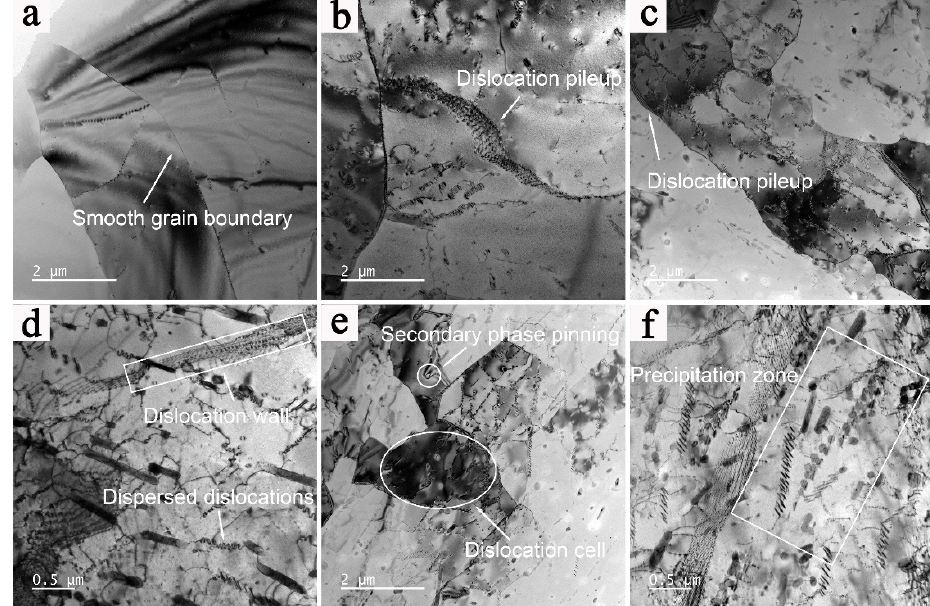
Figure 12. TEM images of the 2198 alloy hot-deformed at di ff erent strain rates: ( a ) 510 °C/0.01 s − 1 , ( b ) 510 °C/0.1 s − 1 , ( c , d ) 390 °C/0.1 s − 1 , and ( e , f ) 390 °C/1 s − 1 .